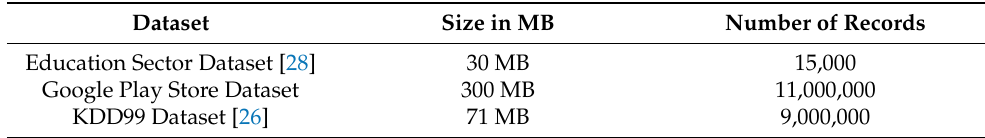
Table 2. Dataset characteristics.